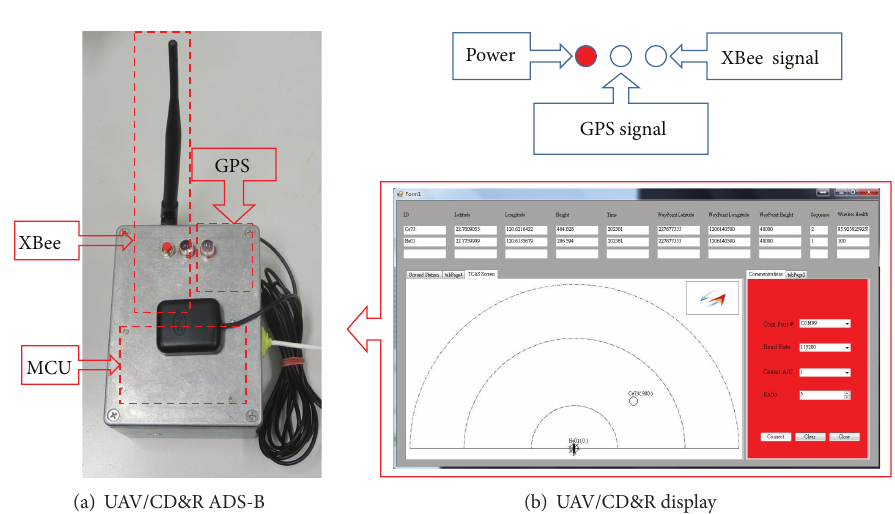
Figure 4: UAV/CD&R transceiver for UAV (left only) and for manned aircraft (all).